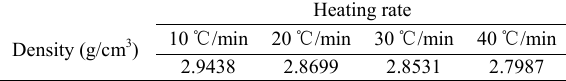
Table 3 Density of SiC fiber at different heating rates